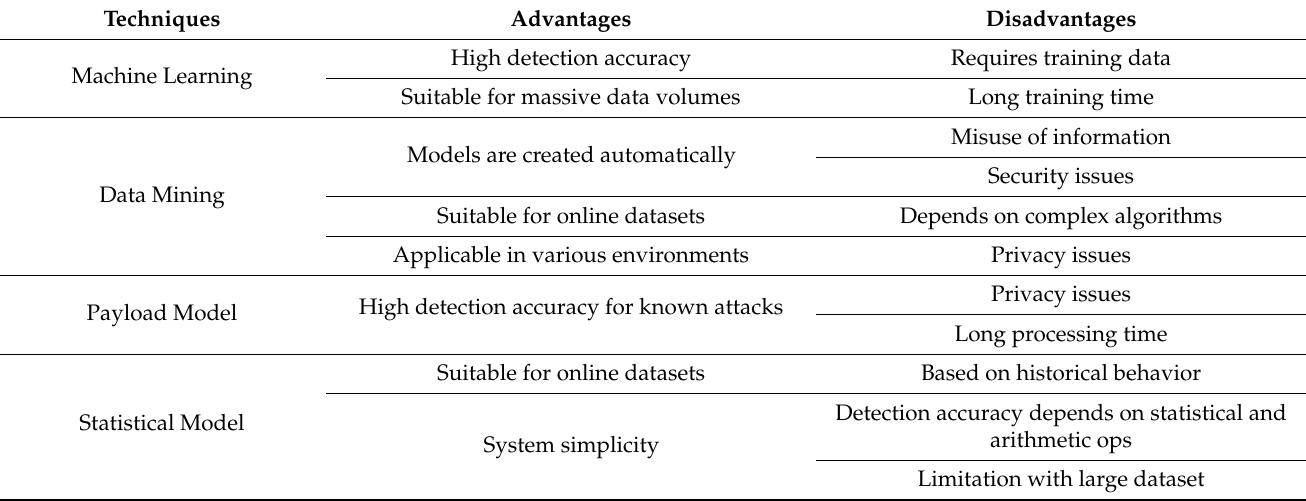
Table 3. Advantage and disadvantage of Anomaly-based IDS detection